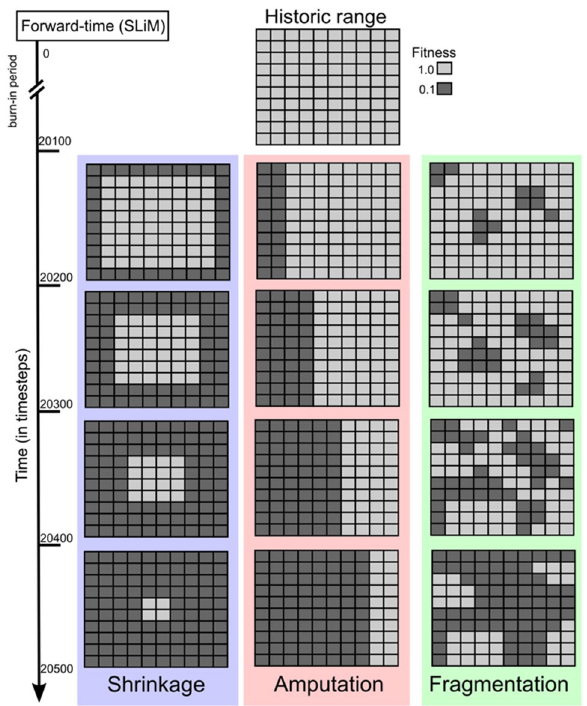
Figure 1. Representation of the simulation of three patterns of range contraction: amputation, shrinkage, and fragmentation. The historic range is represented at the top of the figure, with light gray squares representing habitat fitness of 1.0. Below are the three range contraction scenarios, with the darker grey squares representing fitness values of 0.1. The y-axis is time (in simulation time-steps), with each contraction occurring in a discrete interval. The landscapes are here shown as grids for simplicity, but note fitnesses are interpolated across cells for smooth